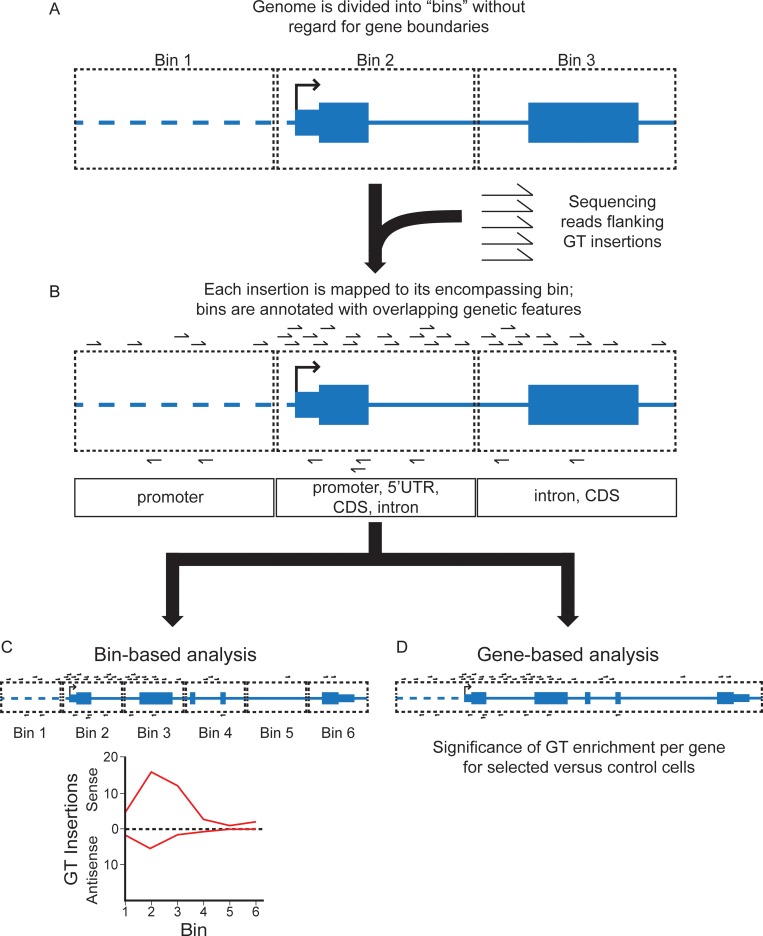
Schematic of Bin-based Analysis of Insertional Mutagenesis Screens (BAIMS).(A) The human genome is computationally divided into “bins” (pictured as rectangles with black dotted lines), which encompass contiguous segments of DNA of an equal arbitrary length. Throughout this study, we used bins of 250 bp or 1000 bp in length, depending on the resolution required for the analysis. The boundaries of annotated genetic features, including genes and regulatory elements, are ignored. The depicted fictitious gene is modeled after a RefSeq gene track following the University of California, Santa Cruz (UCSC) genome browser display conventions: coding exons are represented by tall blocks, UTRs by shorter blocks, and introns by horizontal lines connecting the blocks. The arrow indicates the gene’s TSS. (B) Sequencing reads flanking the location of individual GT insertions in the control and selected cell populations from a haploid genetic screen are mapped to the human genome and assigned to the bin that encompasses the location of the insertion. The orientation of each insertion relative to the chromosome is noted. Bins are also annotated with any overlapping genetic features. These include promoter (defined as the 2000 bp upstream of the TSS, indicated by a horizontal dotted line), 5’UTR, CDS, intron, and 3’UTR. The orientation of the feature relative to the chromosome is also noted. (C) For the bin-based analysis, the number and orientation of GT insertions in consecutive bins along any defined portion of the genome (including but not limited to genes) is determined and can be depicted in a histogram (the number of sense GT insertions per bin is arbitrarily shown above the horizontal line labeled “0”, and the number of antisense insertions below), enabling the visualization of insertion patterns at sub-gene resolution. (D) For the gene-based analysis, GT insertions in bins that overlap with genes can be summed to obtain a total insertion count for each gene. The significance of GT enrichment for every gene is calculated by comparing the total number of insertions per gene found in the selected versus the control cell populations (see Materials and methods for details).